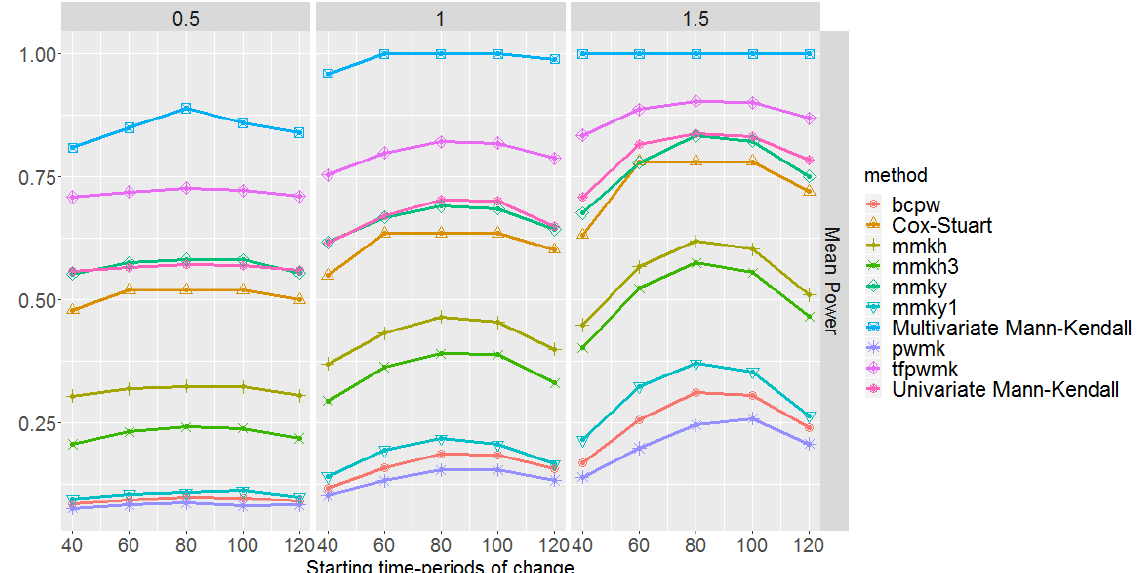
Figure 8. Mean empirical power of the tests of the trend detection methods with respect to the magnitudes of change 0.5,1, and 1.5, and starting time-periods of change 40,60, . . . ,120. These are based on 100 simulations of multi-layer rasters under the second scenario, where pixel time series are generated from an autoregressive model with parameter 0.8.